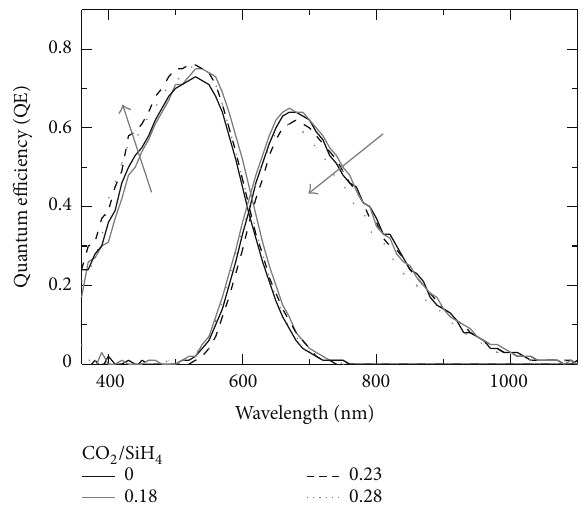
Figure 6: QE of a-SiO:H/ 𝜇 c-Si:H micromorph silicon solar cells using n top 𝜇 c-Si(O):H layer deposited with various CO 2 /SiH 2